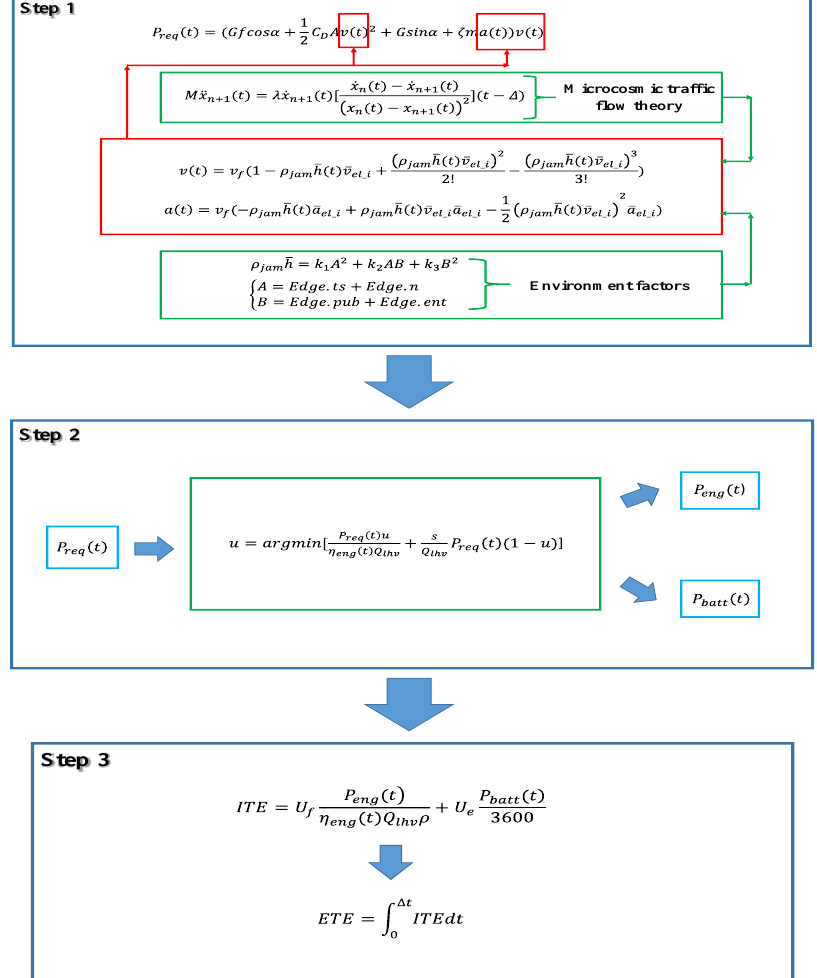
Figure 6. Illustration of the three